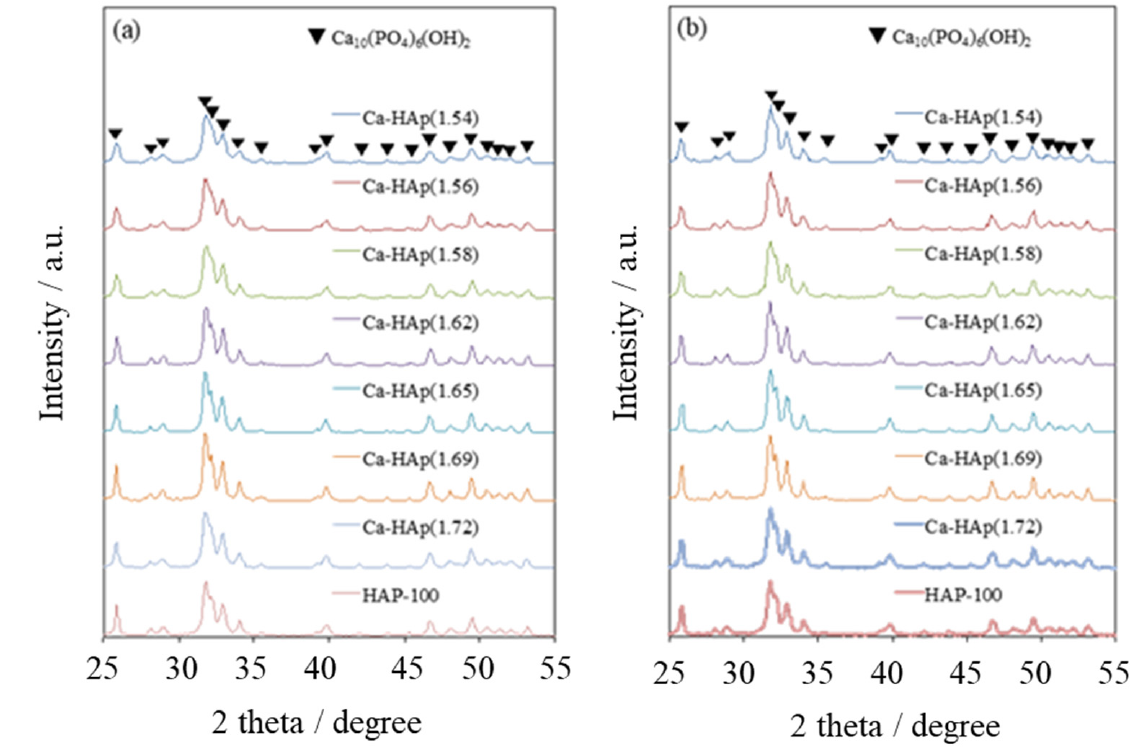
Figure 1. Powder X-ray diffraction (XRD) patterns of hydroxyapatites ( a ) as-prepared and ( b ) after conversion of 1,6-hexanediol.